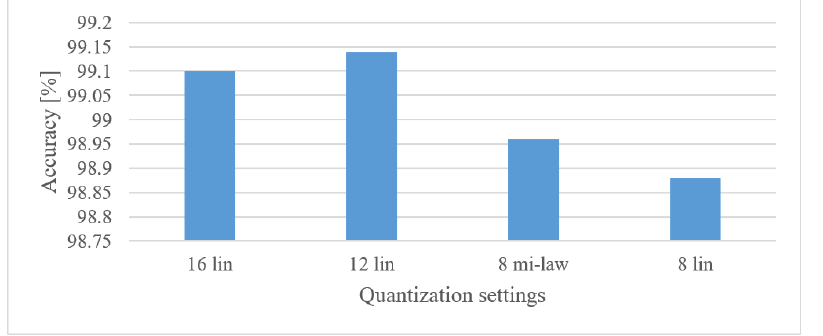
Figure 17. Accuracies for 16, 12, and 8 bit linear, and 8 bit μ -law quantization schemes for 0–10 kHz spectrograms.